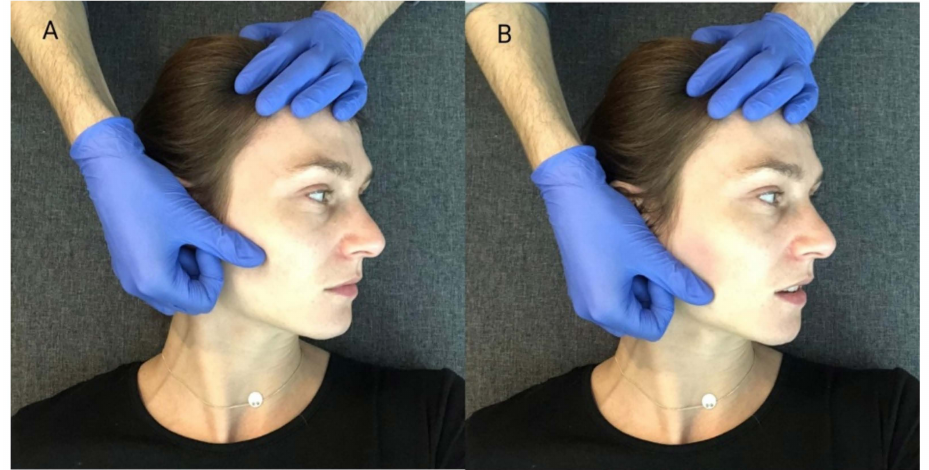
Figure 6. MR procedure of the masseter muscle on the right side: ( A ) tacking out the tissue slack; ( B ) Mobilization of the myofascial